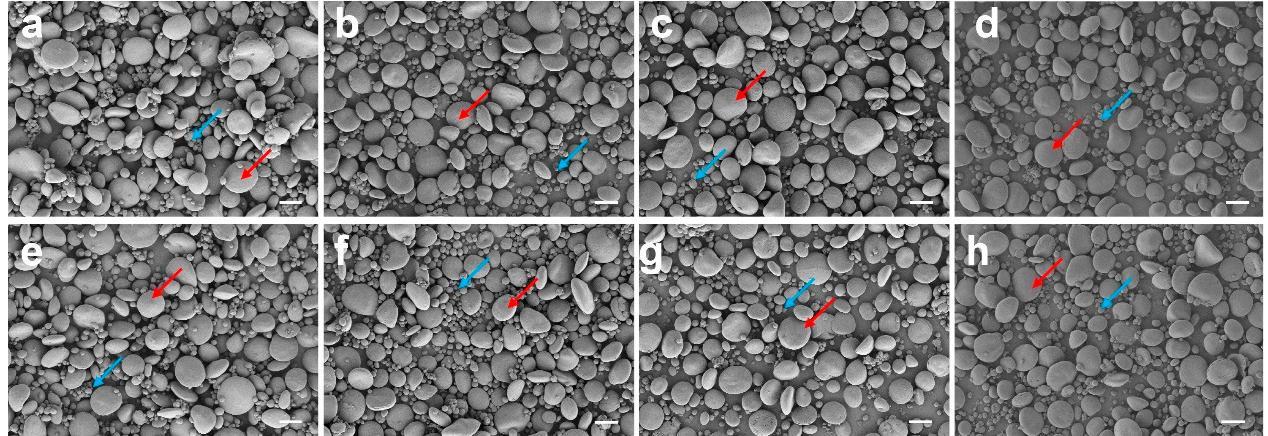
Figure 7. Starch granule in mature wheat grains of the mtl mutants. ( a ) “Fielder” (WT); ( b – d ) Normal grains from mtl-AD , mtl-BD , and mtl-ABD ; ( e ) Normal grains from mtl-A ; ( f – h ) Embryoless grains from mtl-AD , mtl-BD , and mtl-ABD . The red arrows indicated A-type starch granules and blue arrows indicated B-type starch granules, scale bar = 20 μ m.